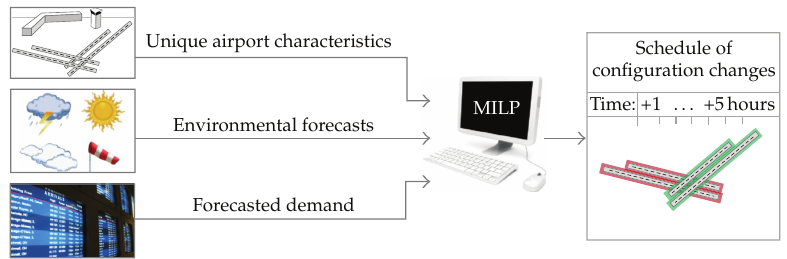
Figure 4: The RCM problem uses a mixed integer linear program to recommend scheduled configuration